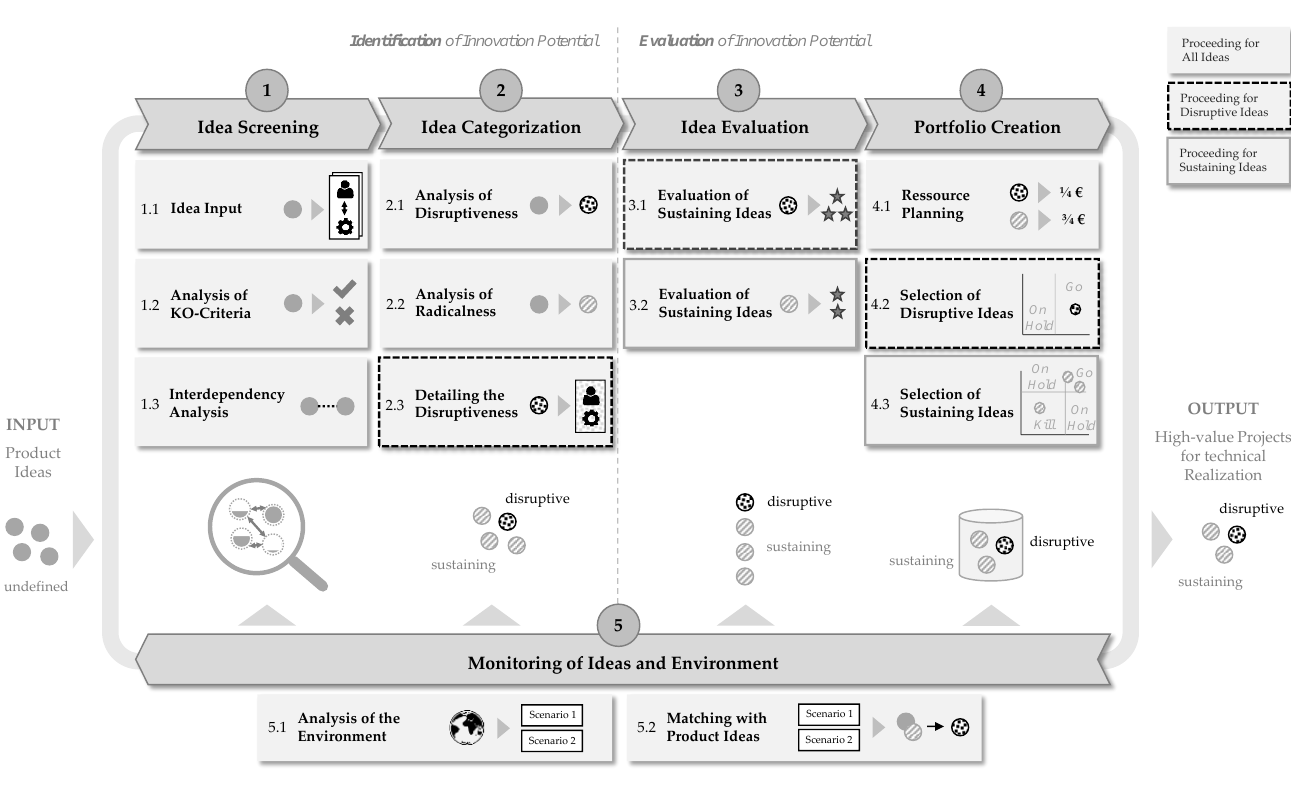
Figure 2. Methodology to integrate disruptive innovation into value-oriented portfolio planning, based on [7].